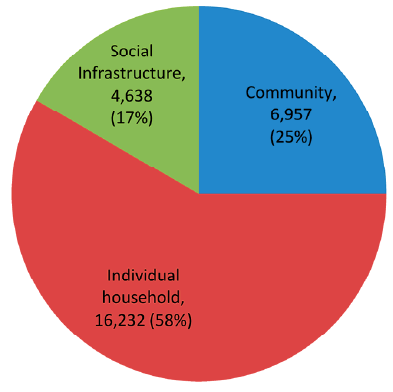
Figure 8. Suggestions on distribution of funds of carbon payments to local villagers.